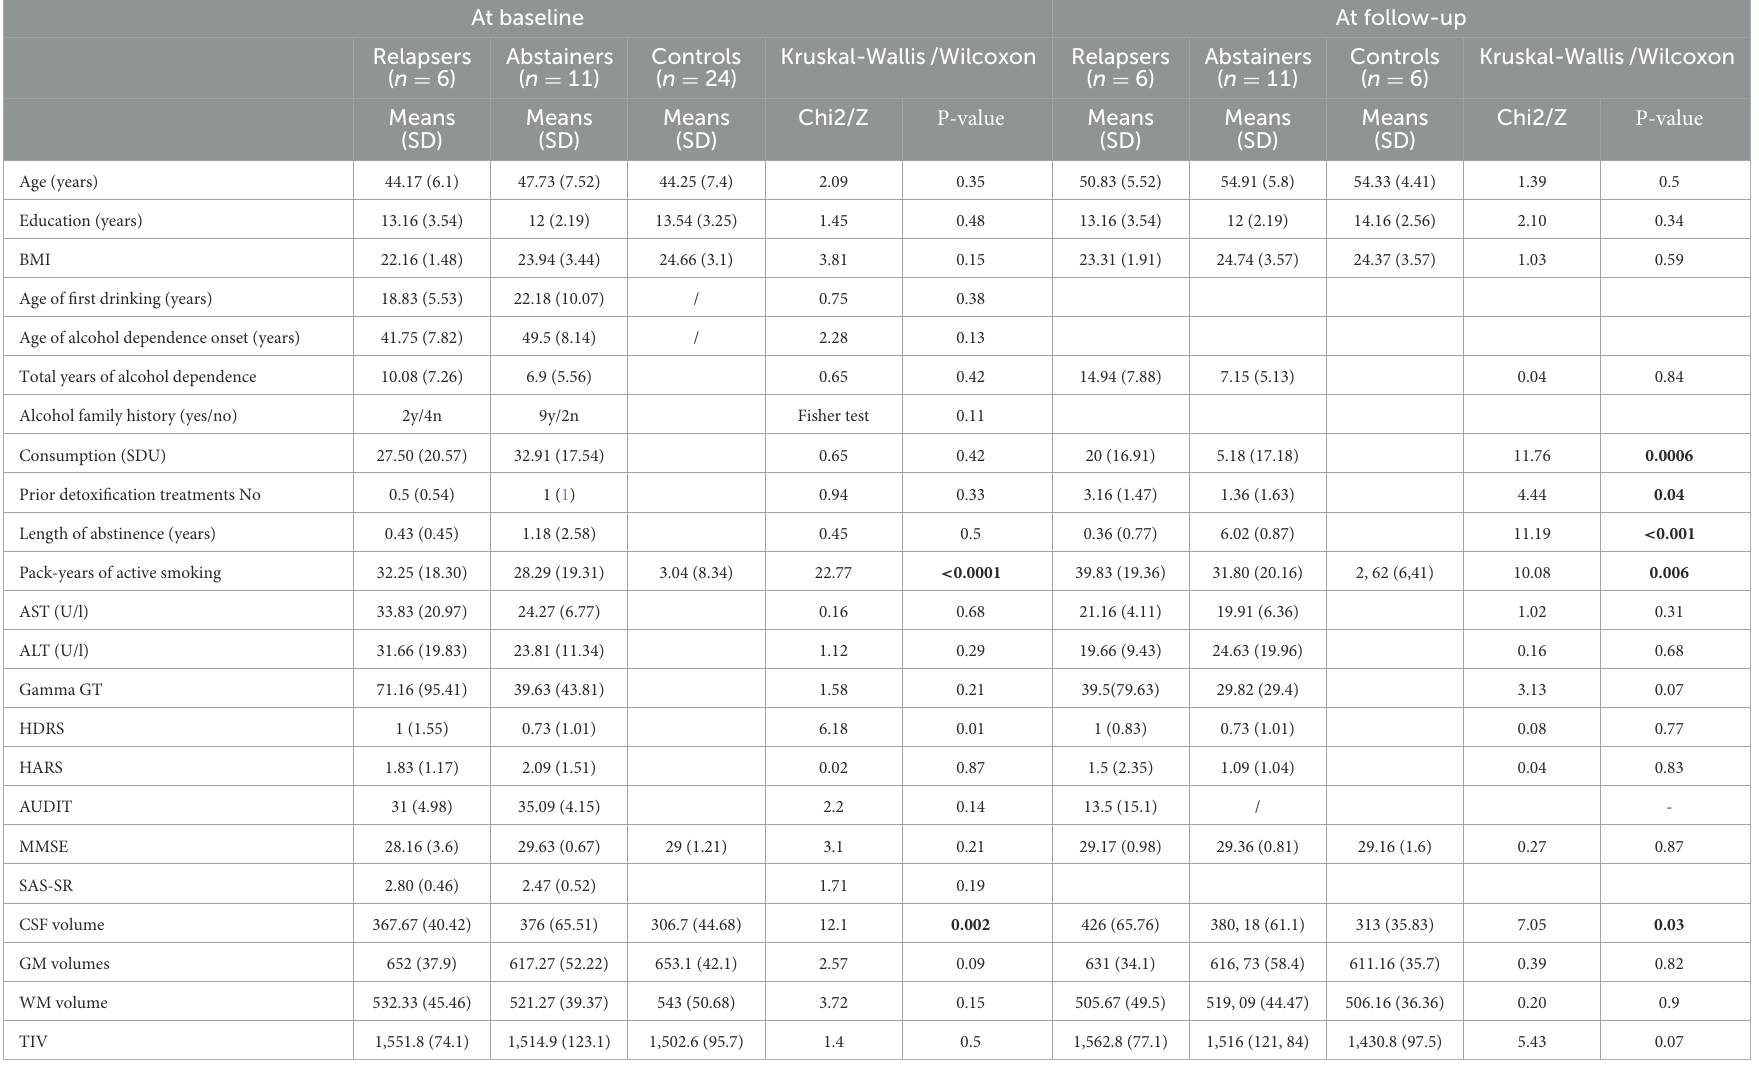
TABLE 1 Characteristics of the three participant groups and whole brain volumes at baseline and follow-up. At baseline At follow-up Relapsers ( n =